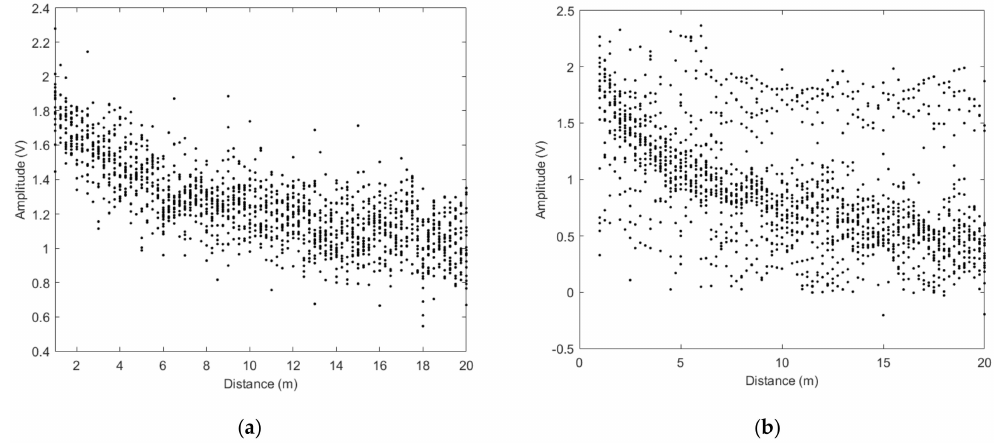
Figure 4. Collected raw partial discharge (PD) UHF received signal strength indicator (RSSI) measurements along a 20 m range. ( a ) LOS conditions; ( b ) NLOS